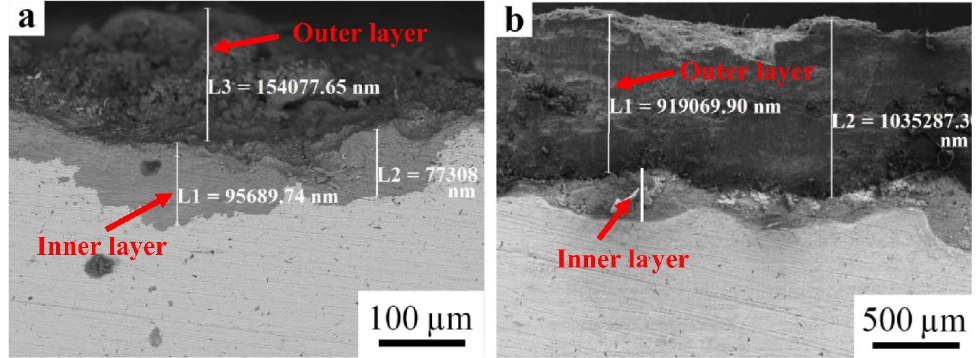
Figure 5. SEM images of cross-sections: ( a ) natural atmospheric corrosion; ( b ) accelerated corro- sion